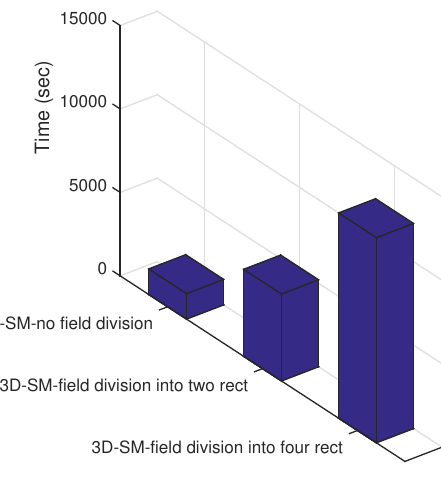
Figure 2. Impact of sub-regions on